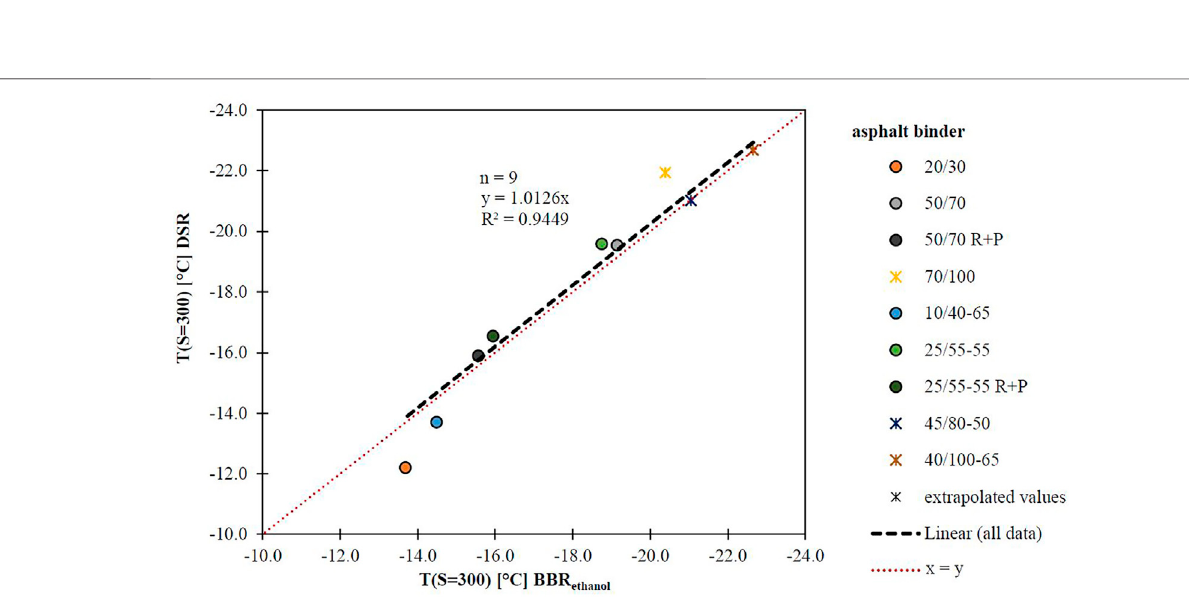
Frontiers in Materials |